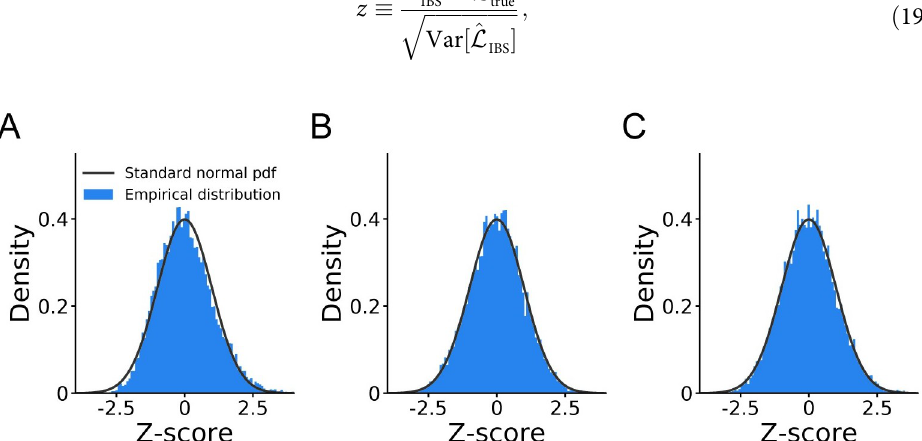
Fig 3. Normality of the IBS estimator. A . z -score plot for the total number of samples used by IBS. B . z -score plot for the estimates returned by IBS, using the exact variance formula for known probability. C . Calibration plot for the estimates returned by IBS, using the variance estimate from Eq 16. These figures show that the number of samples taken by IBS and the estimated log-likelihood are (approximately) Gaussian, and that the variance estimate from Eq 16 is